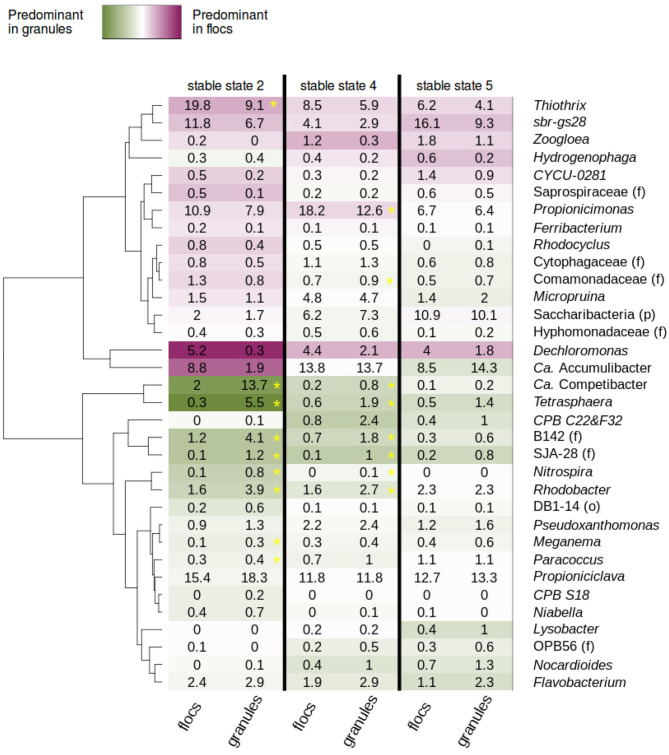
Granules and flocs heatmap showing the average relative abundance of the abundant taxa in AGS fed with complex monomeric wastewater during stable states 2, 4, and 5. The flocs and granules data of stable state 3 were too sparse for this analysis. Green indicates a higher proportion in granules, purple a higher proportion in flocs. In order to lower the possible effect of noise in the very low abundant taxa, a pseudo-count of 0.5% was added to each abundance for the color code and the significance analysis. A yellow asterisk indicates the differences that are significant with an adjusted p-value of 2.94 × 10−4 (0.01/34).